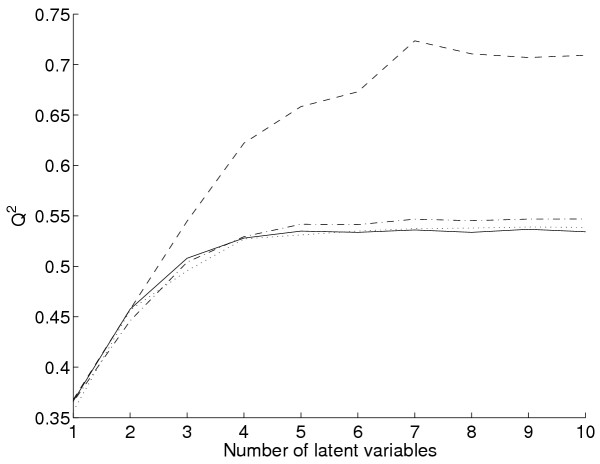
Comparison of software. Q2 values obtained using different software for the prediction of affinities based on PLS models, without variable selection, for the amine data set. Between one and ten latent variables were used and SIMCA (dashed line), UNSCRAMBLER (dash-dotted line), GOLPE (dotted line) and MATLAB (solid line) were used to both build the models and evaluate them by computing Q2 values. The SIMCA Q2 values are much higher than the other Q2 values.